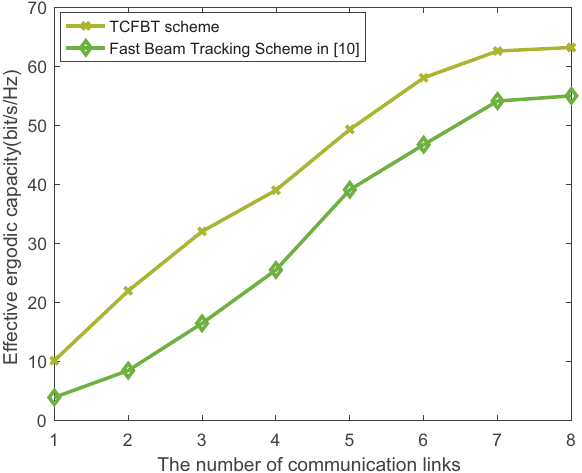
Figure 13. The effective ergodic capacity vs. different 5G communication